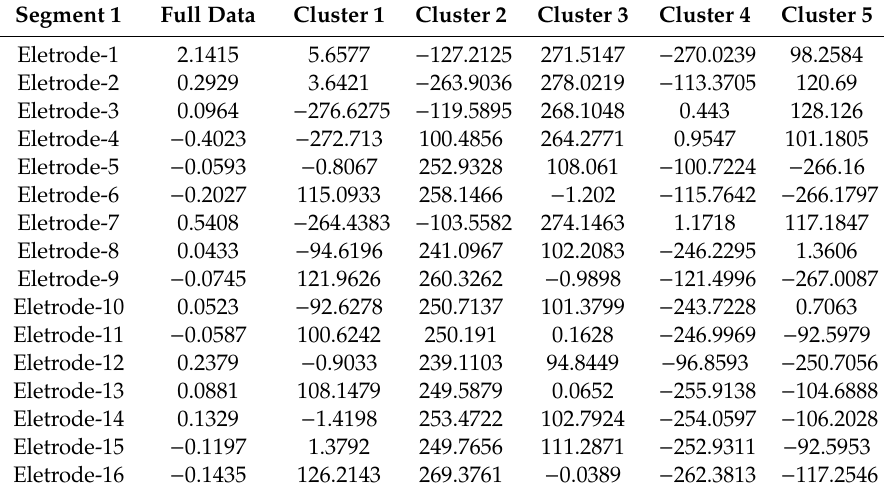
Table 1. K-means clustering based on EEG Poisson distribution approximation (PDA) sampling data (left-hand